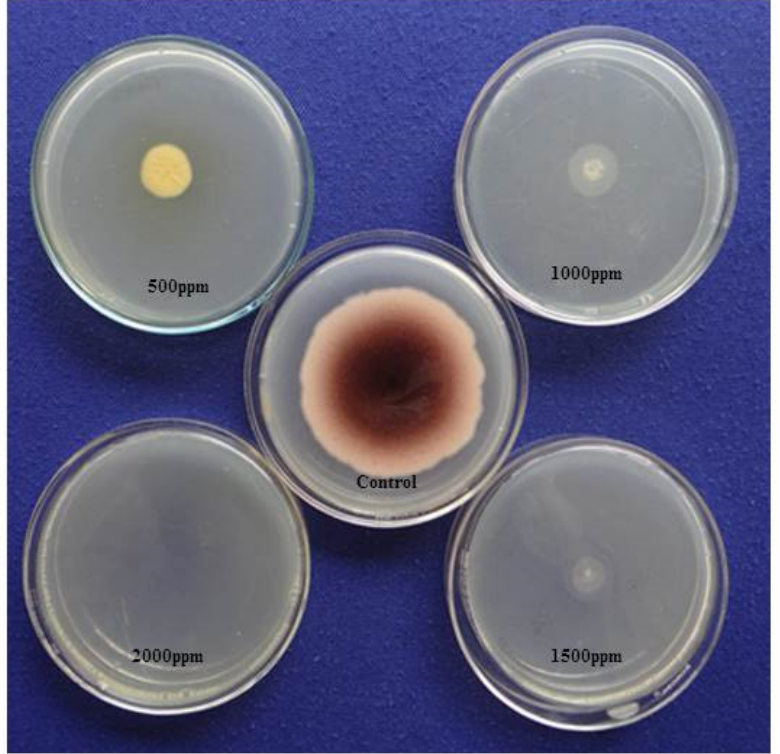
Figure 4. Effect of clove essential oil on aflatoxin (AFB1) production by A. flavus on yeast extract sucrose (YES) medium exposed to ammonia vapor.